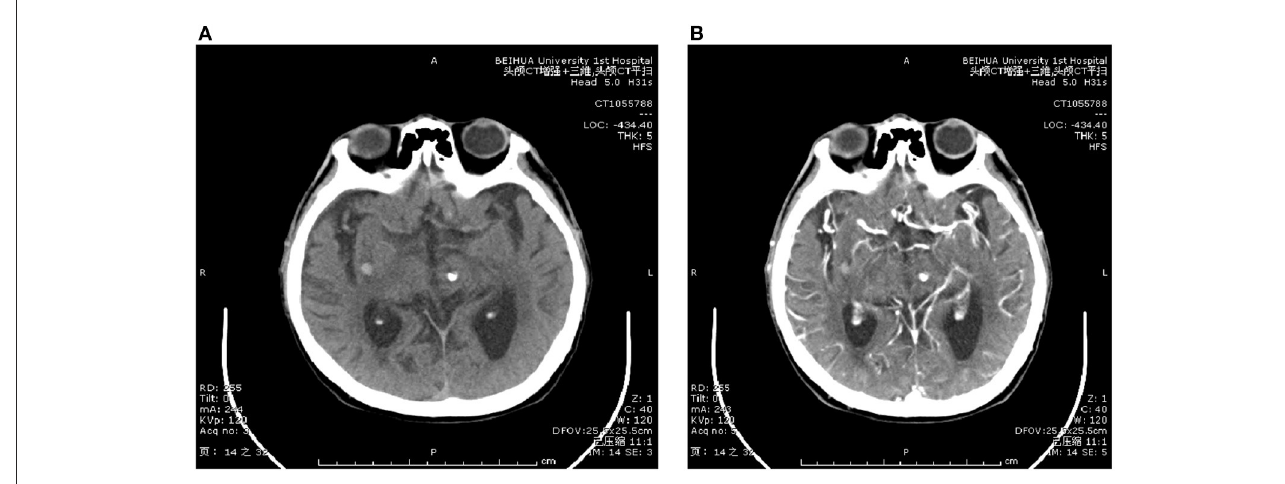
FIGURE1 CT scanning image. (A) Shows CT plain scan image and (B) shows CT enhanced image.